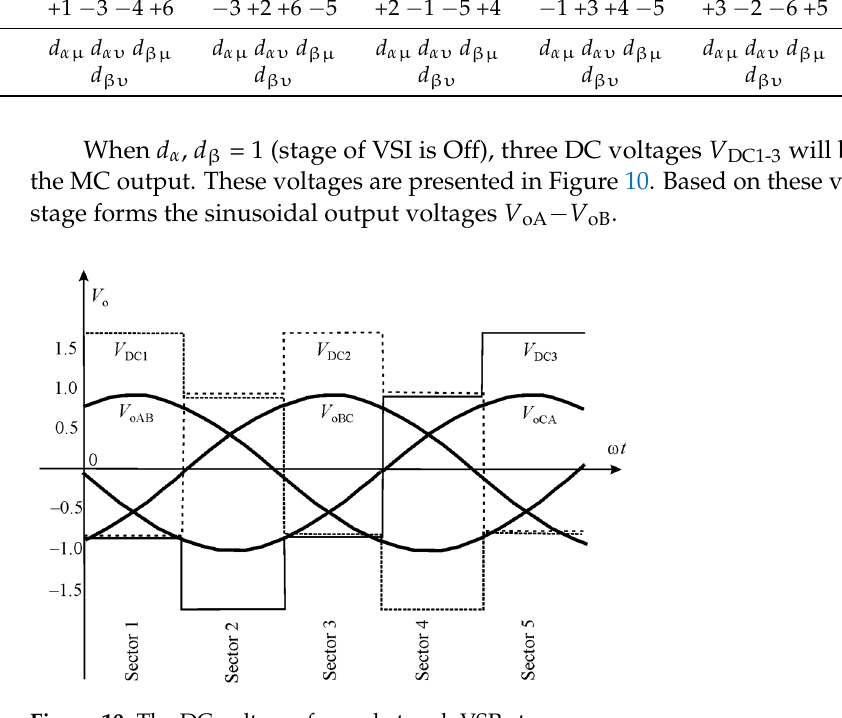
Figure 10. The DC voltages formed at each VSR stage. The ISVM ensures a voltage transfer rate of 0.866, but this value is not